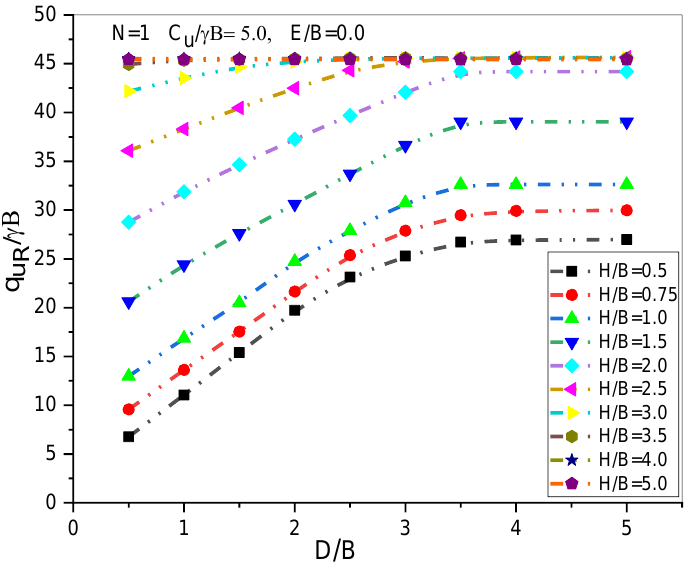
Figure 14. Effect of reinforcement on the ultimate bearing capacity ratio when the vertical distance of the void is altered.